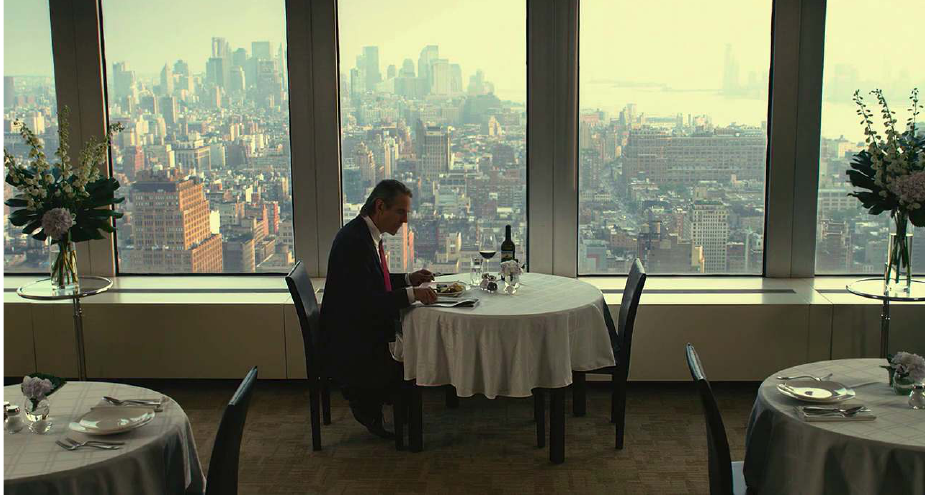
Source: Margin Call by J. C. Chandor (screen